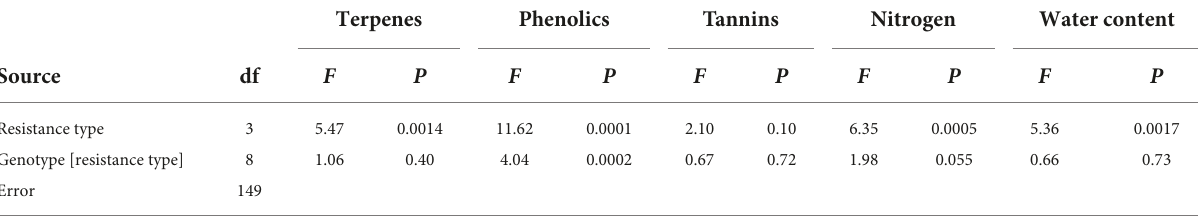
TABLE 1 ANOVA results testing for patterns in the foliar chemistry of ungalled leaves among four resistance types, each represented by three clones or species. Terpenes Phenolics Tannins